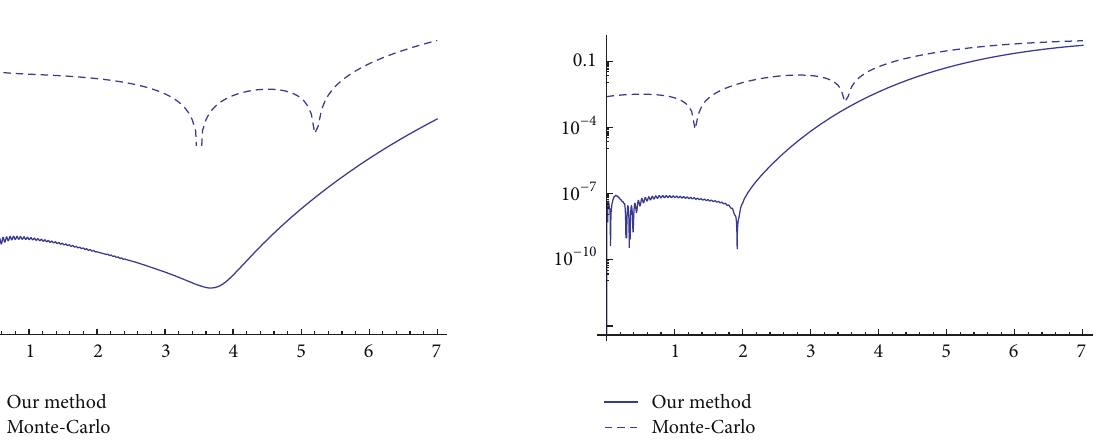
Figure 2: Relative errors of the approximations to the standard deviation of the solution s.p. 𝑦(𝑡) on the interval [0,7] in Example 1 by the proposed method and Monte-Carlo simulations. To highlight better the differences, a logarithmic scale has been used in the vertical axis.